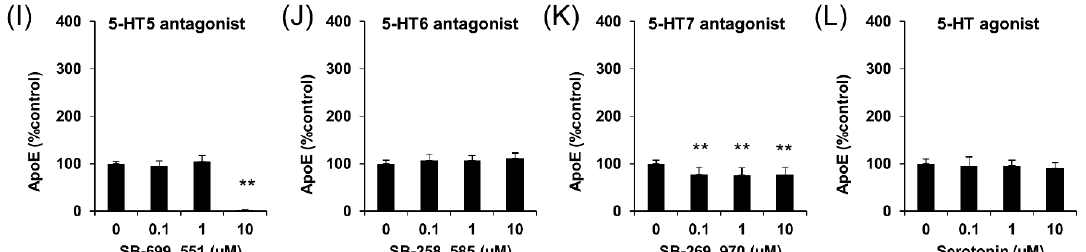
Figure 2. Effects of different 5-HT receptor antagonists on apoE secretion in immortalized astrocytes. apoE levels in culture media of immortalized astrocytes derived from apoE3-TR mice were determined by ELISA after treatment for 24 h with the indicated concentrations of ( A ) OS, ( B ) Methysergide, ( C ) Ketanserin, ( D ) Clozapine, ( E ) Granisetron, ( F ) Dolasetron, ( G ) Tropisetron, ( H ) GR-113,808, ( I ) SB-699,551, ( J ) SB-258,585, ( K ) SB-269,970, and ( L ) Serotonin. Data represent mean ±